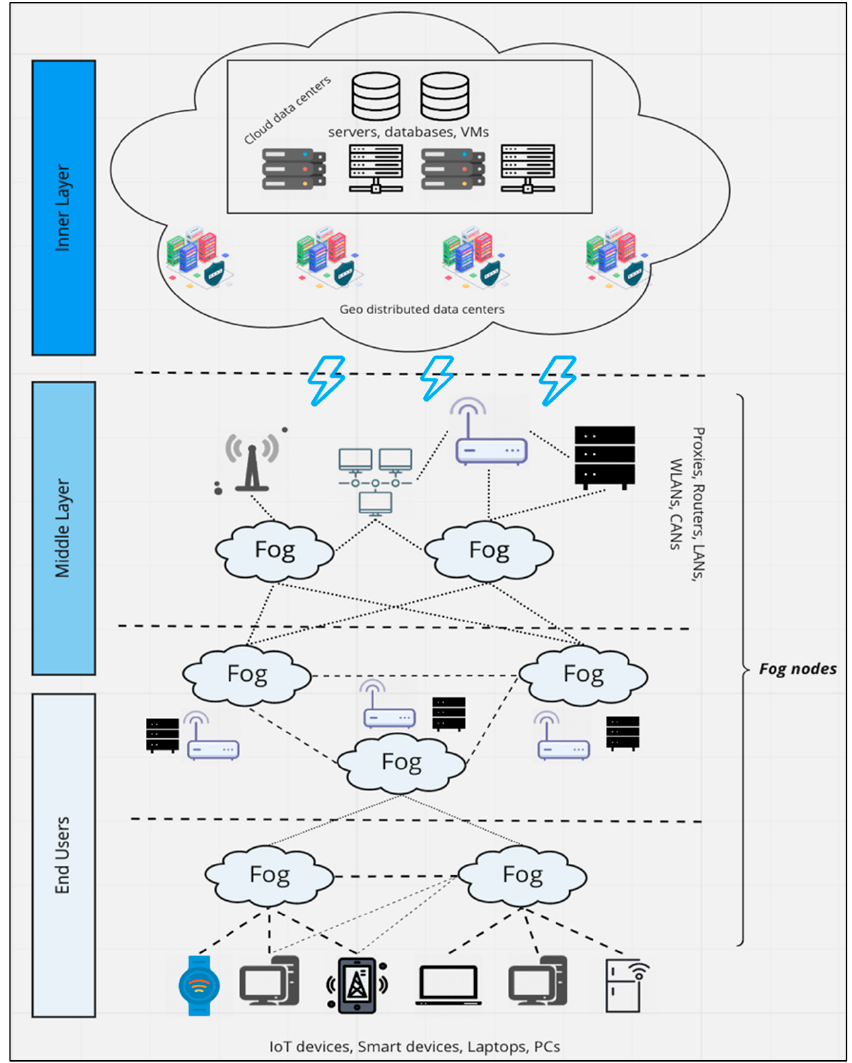
Figure 2. Fog network architecture.